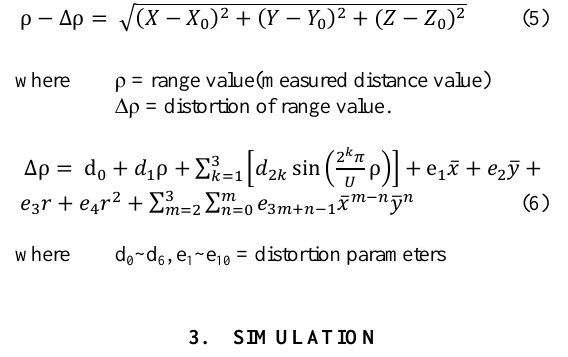
Figure 4. is flow chart of simulation. Simulation consists of steps which are i) predetermination of parameters, coefficients and shooting location, ii) image production, iii)